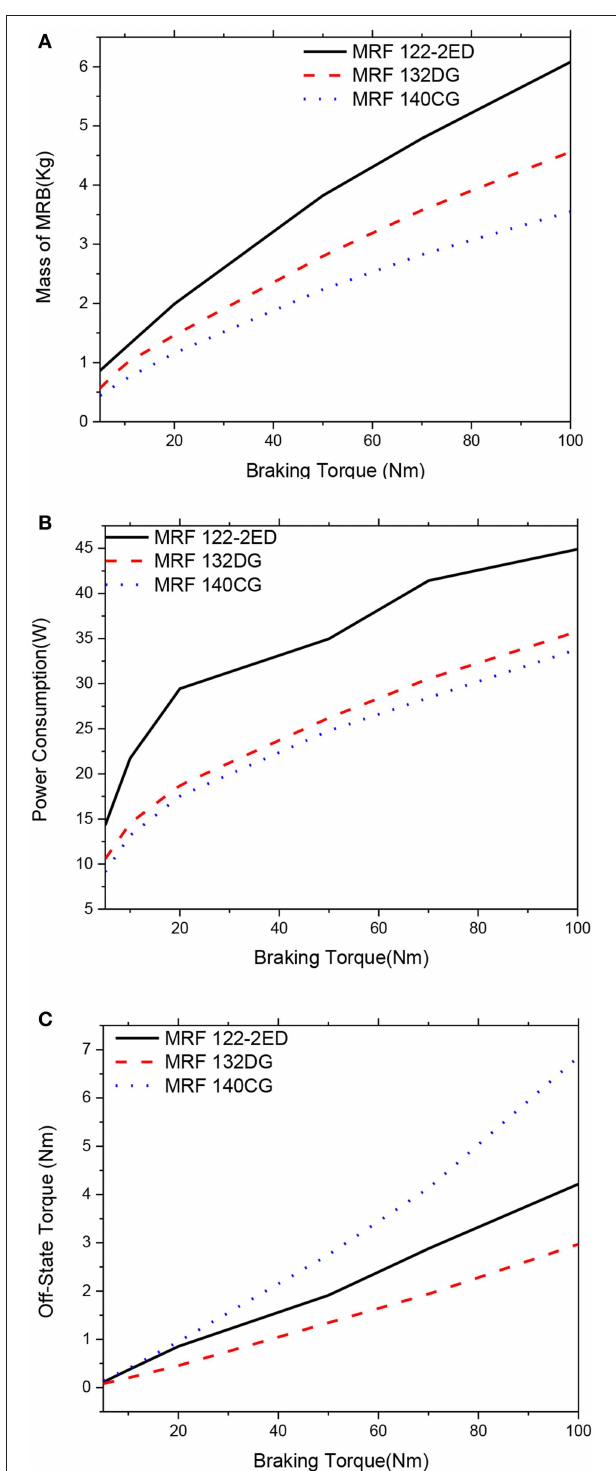
FIGURE 7 | Mass optimization results of the MRBs as a function of braking torque of side-coil MRB, d = 0.6mm. (A) Mass as a function of braking torque, (B) Power consumption as a function of braking torque, (C) Off-state torque as a function of braking torque.